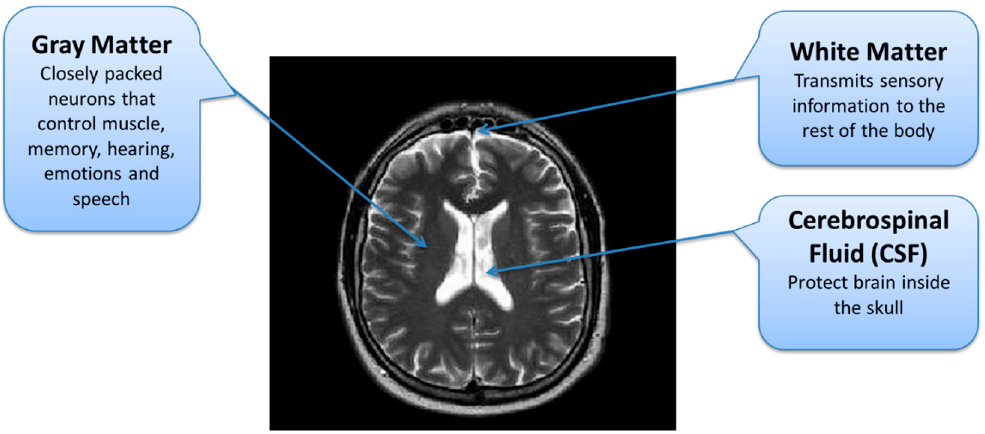
Figure 4. Brain MRI Tissues Types.